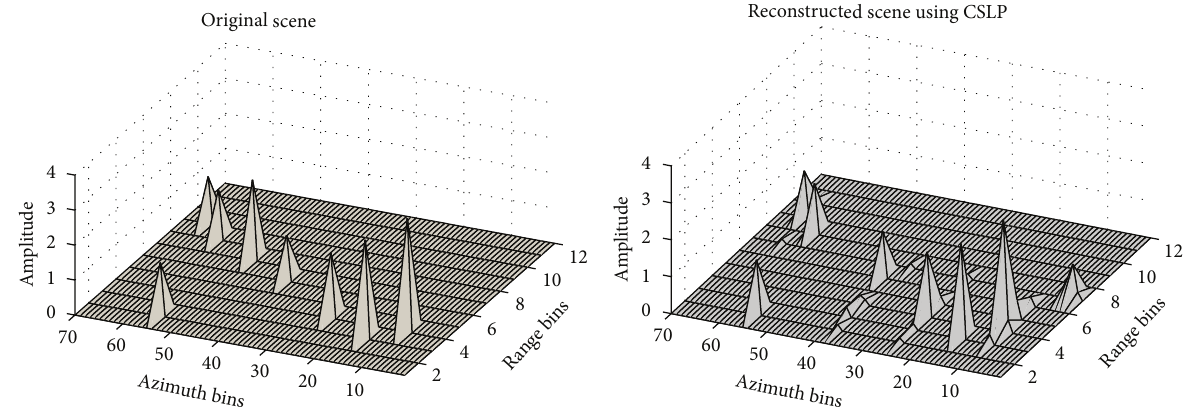
(a) Original scene used for showing effects of range and azimuth pixels mismatch